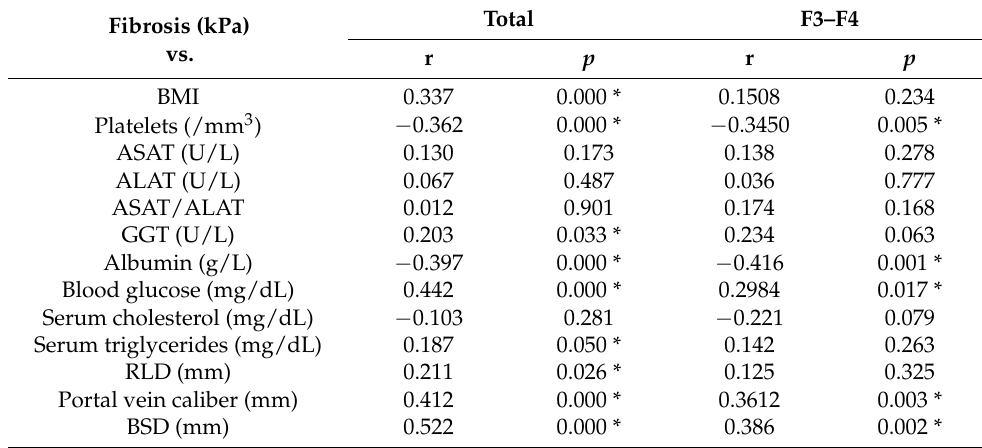
Table 3. Pearson correlation coefficients between parameters analyzed and liver